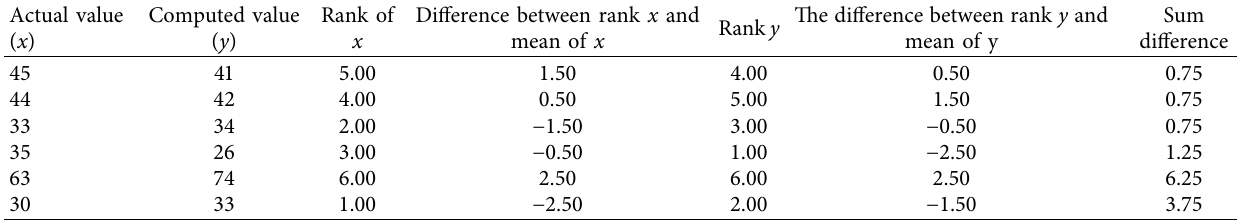
Figure 4: (a, b) Accuracy analysis; (c, d) sensitivity analysis; (e, f) correlation analysis; (g, h) error rate analysis of Table 3: Spearman’s rho correlation analysis.